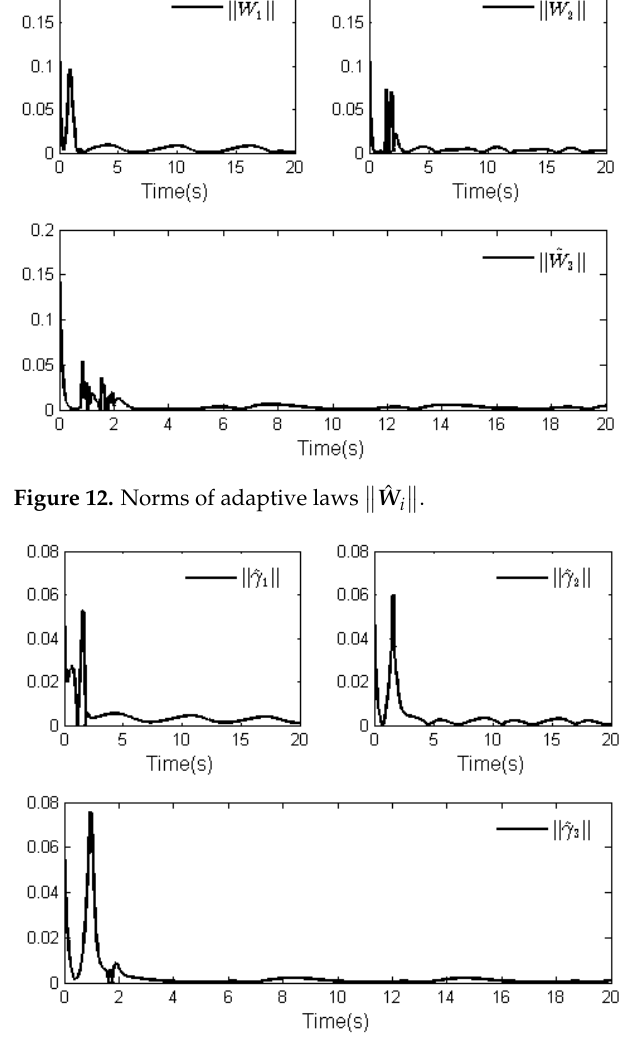
Figure 13. Norms of adaptive laws (cid:107) ˆ γ i (cid:107)